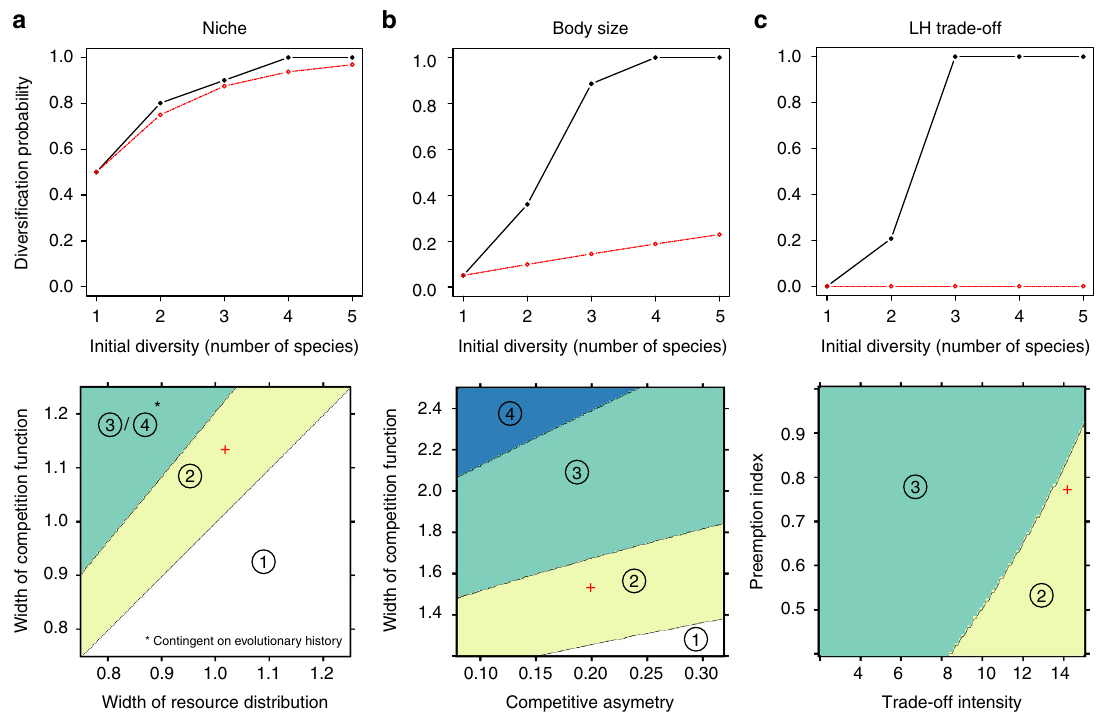
Figure 3 | Diversification likelihood increases with diversity. The likelihood of adaptive radiation (fraction of parameter space conducive to adaptive radiation) is shown as a function of initial diversity under the three ecological scenarios ( a – c ; top). Red dotted lines represent the null expectation if the per-species probability of diversification remained constant regardless of initial diversity. Also shown is the minimum initial diversity needed to observe an adaptive radiation, as a function of parameter values, under the three ecological scenarios ( a – c ; bottom). ‘1’ indicates parameter combinations such that one-species evolution results in a classical radiation, ‘2’ those such that adaptive radiation is impossible starting from one species, but is possible starting with two species or more (DDAR), and so on. In the niche scenario, there were alternative evolutionary attractors for three and four species, that differed in evolutionary stability. Hence for a given parameter combination, the minimum initial diversity further depends on historical contingencies, such as the initial trait values of species and the sequence of mutations that occur. Red crosses indicate the parameter combinations used in Fig.